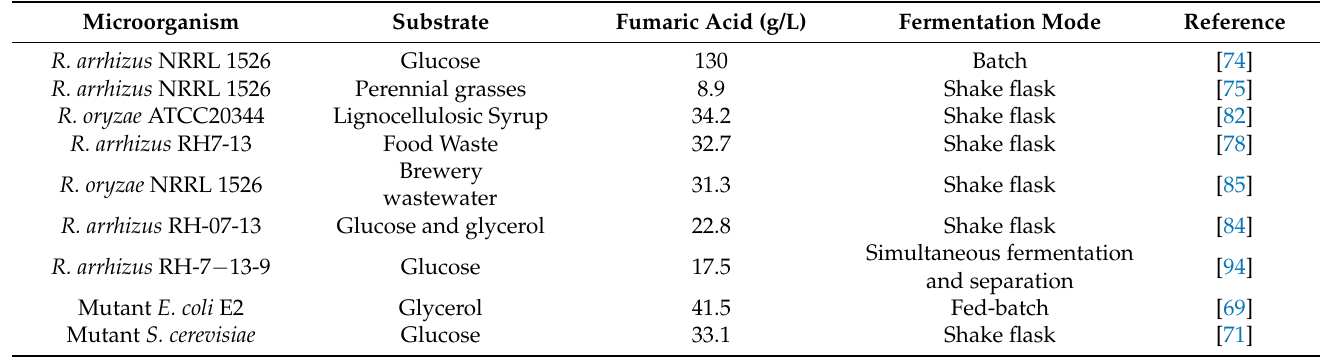
Table 3. Fumaric acid production with different substrates, microorganisms, and fermentation strategies.